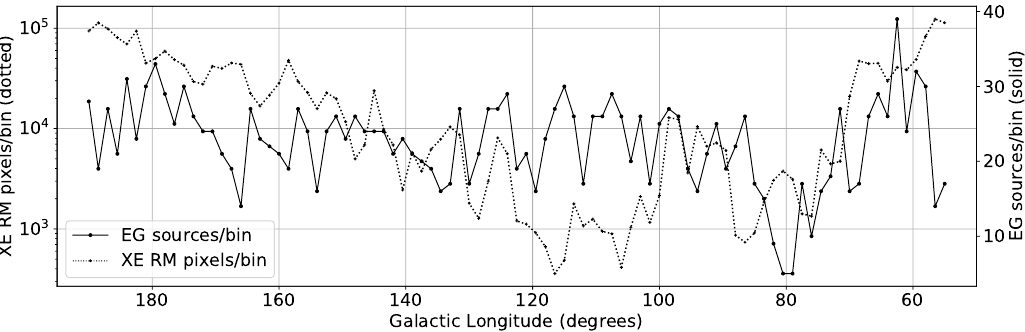
Figure 3. The number of XE RM pixels (dotted line) and EG sources (solid line) contained in independent bins each spanning 1.5 degrees of longitude and covering the CGPS latitudes, b = − 3 ◦ to + 5 ◦